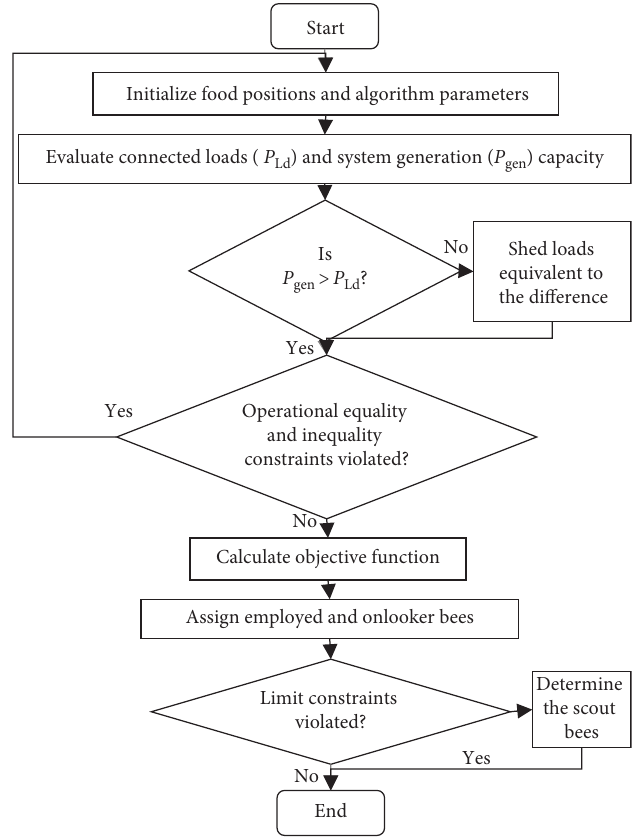
Figure 2: System flow